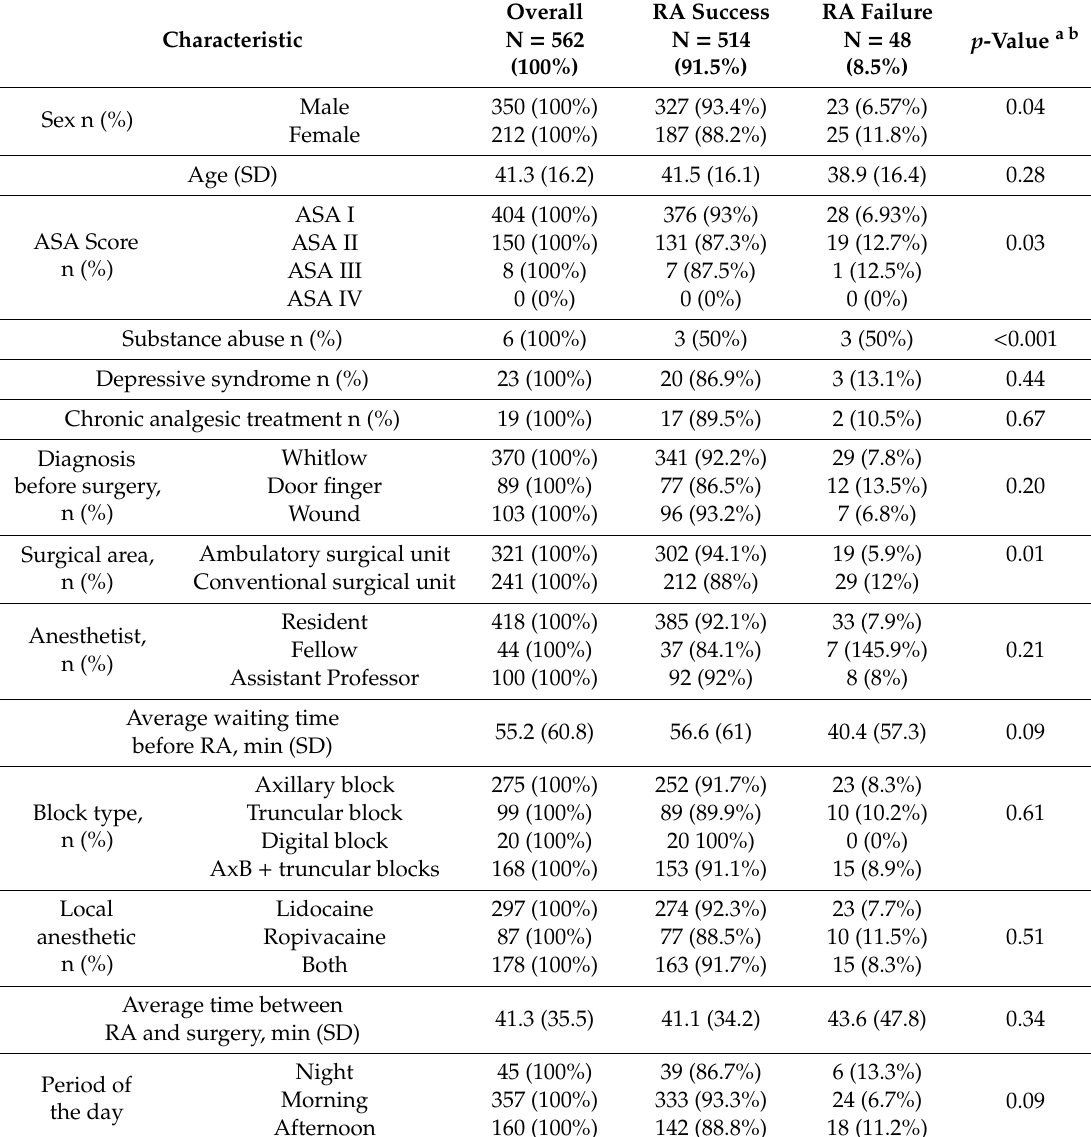
Table 1. Demographic data and surgical and anesthetic management parameters of the patients studied.